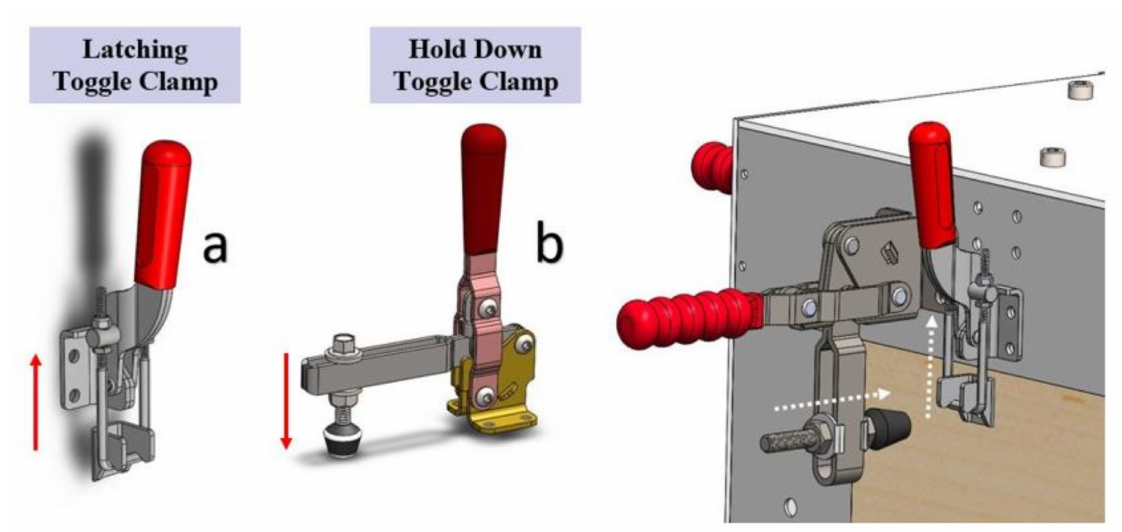
Figure 20. Toggle clamps used in the designed prototype: ( a ) latching toggle clamp and ( b ) hold down toggle clamp.